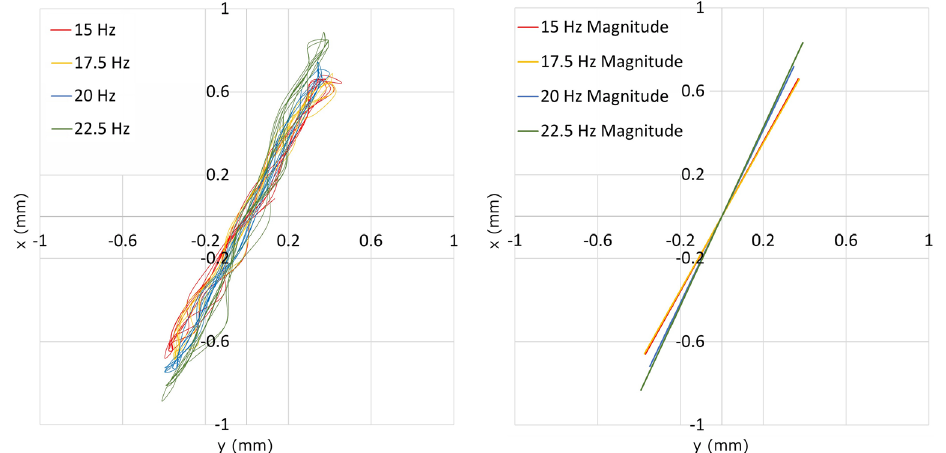
Figure 8. The direction of vibrations (left) and magnitude vibrations (right) of the selected vibration frequencies.